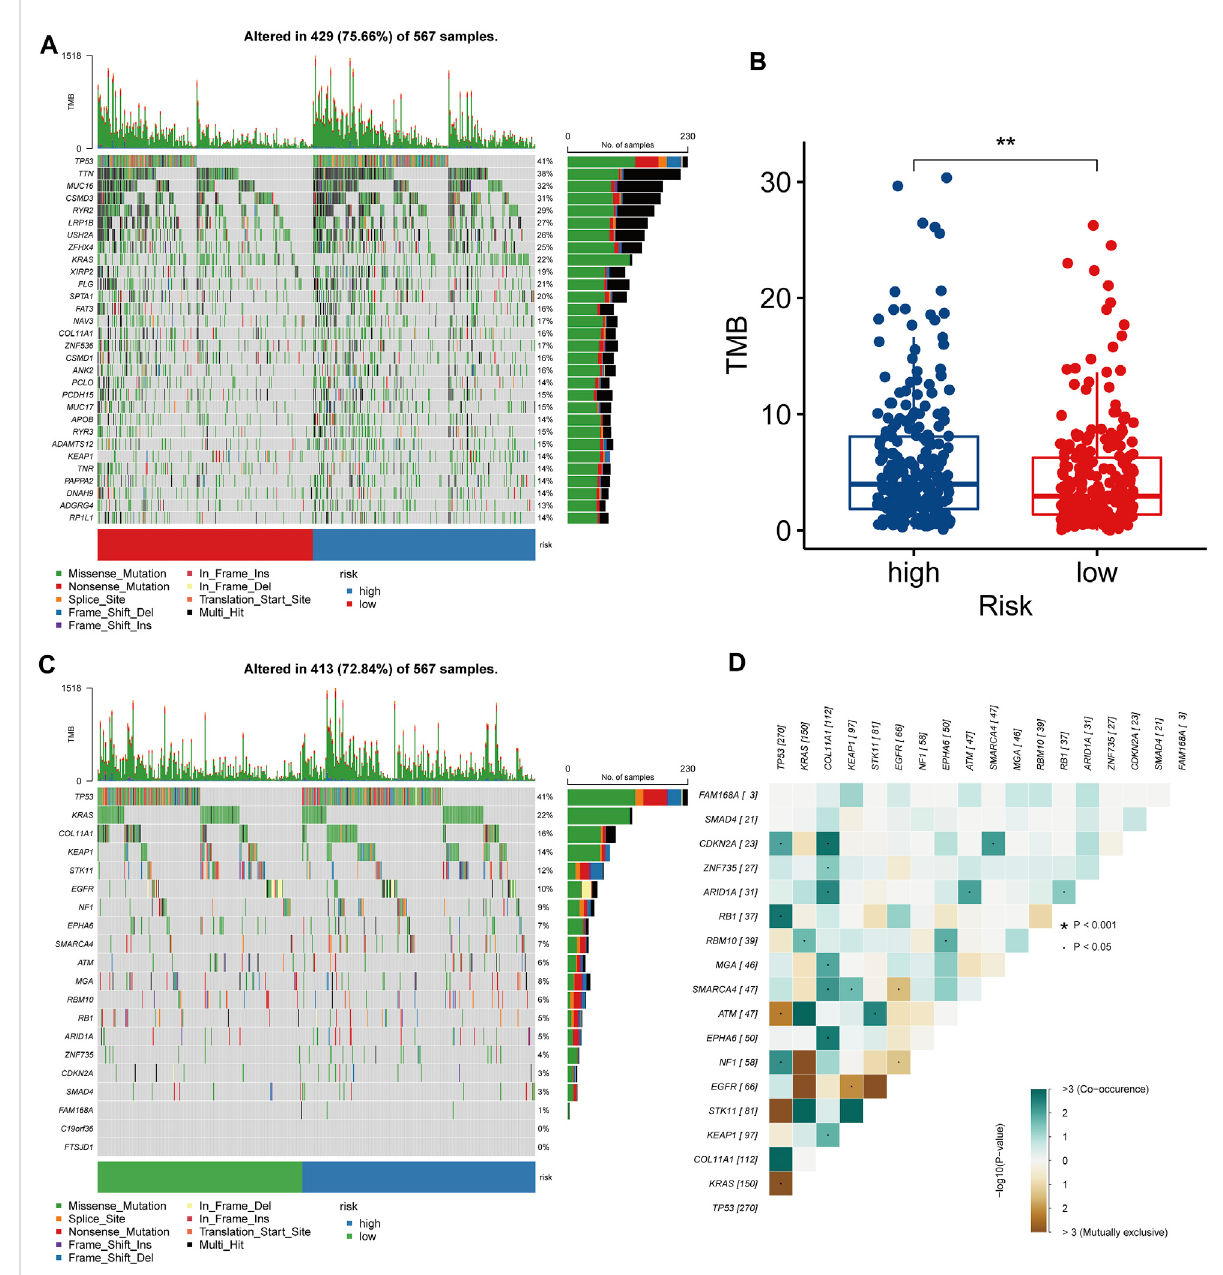
FIGURE 6 Molecular characteristics of two LRPI subgroups (A) The gene mutation landscape of two LRPI subgroups (different colors represent different mutation modes) (B) Boxplots showed the differences in TMB between two subgroups (C) Mutation landscape of driver-mutated genes of two LRPI subgroups (D) Correlations of mutation frequencies among driver-muted genes